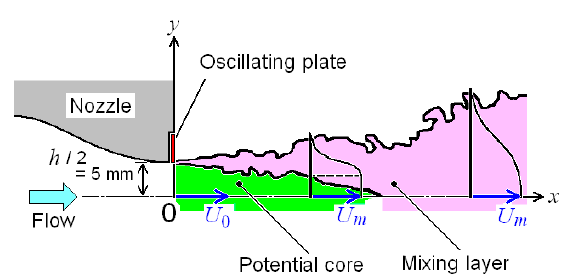
Fig. 5 Schematic diagram of two-dimensional mixing layer and coordinate system.